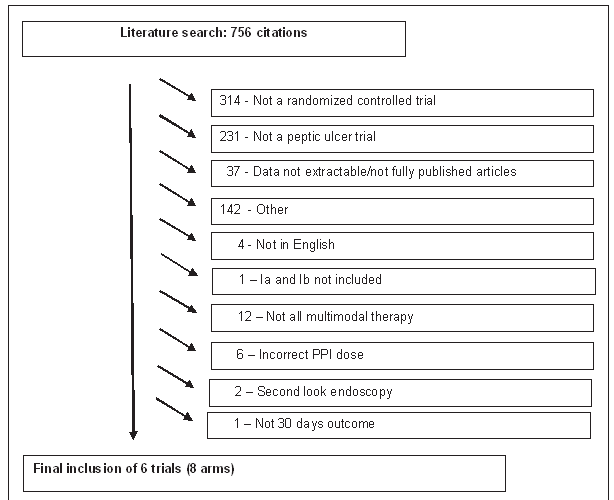
Figure 1) STROBE (STrengthening the Reporting of OBservational studies in Epidemiology) diagram. PPI Proton pump